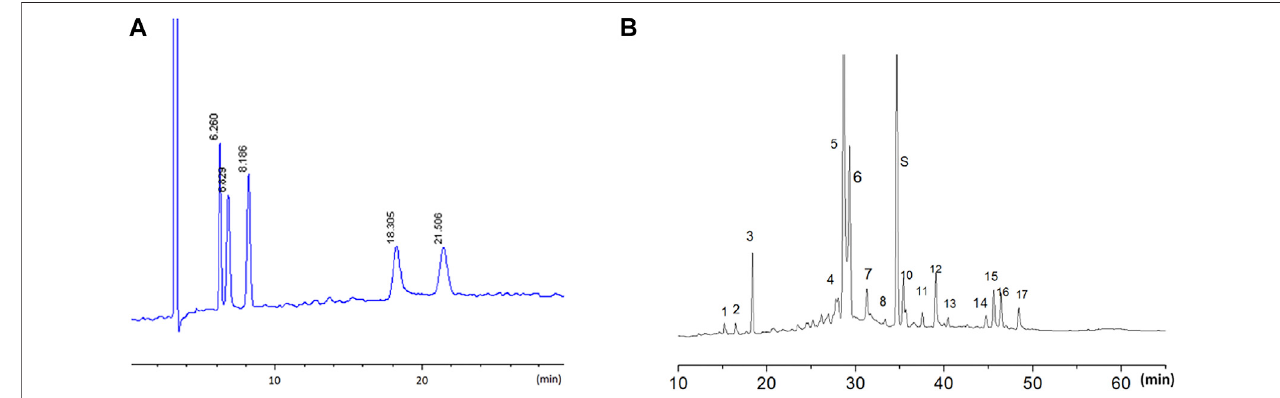
FIGURE 1 | The HPLC fi ngerprint of LW-AFC. LW-AFC consists of polysaccharide fraction (LWB-B), glycoside fraction (LWD-B), and CA-30. (A) The HPLC fi ngerprint of LWB-B and CA30 mixture. The peak at 6.26, 6.83, 8.19, 18.30, and 21.50 min represents, respectively, fructose, glucose, sucrose, mannotriose, and stachyose. (B) The HPLC fi ngerprint of LWD-B. The peak S represents loganin.